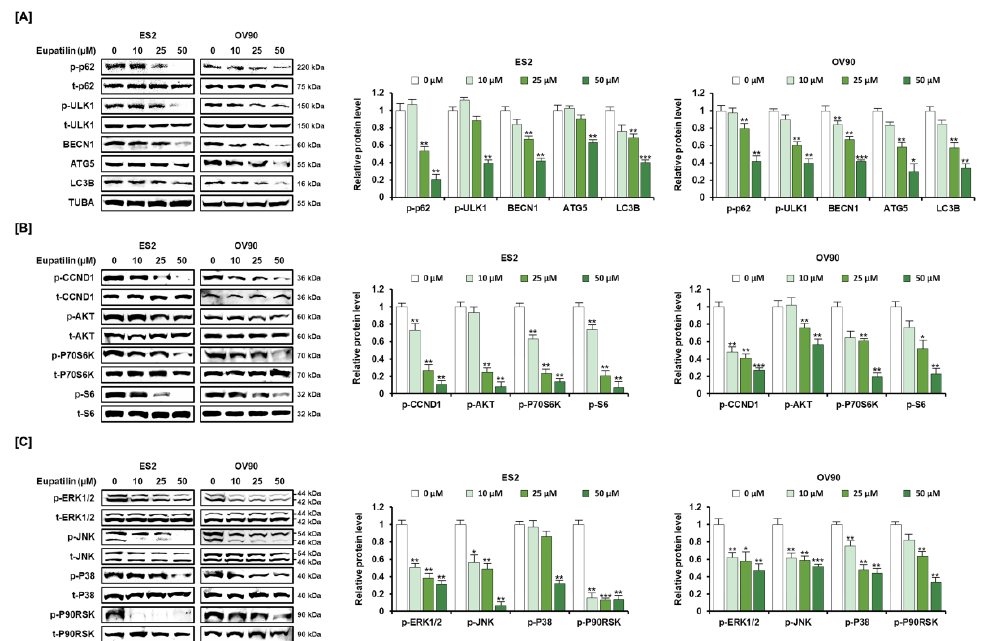
Figure 4. Dose-dependent e ff ects of eupatilin on autophagy, PI3K / AKT, and MAPK signaling in ovarian cancer cells. ( A ) E ff ects of eupatilin on autophagosome formation in ES2 and OV90 cells. [B-C] Inhibitory e ff ects of eupatilin on PI3K ( B ) and MAPK ( C ) signal transduction in ovarian cancer